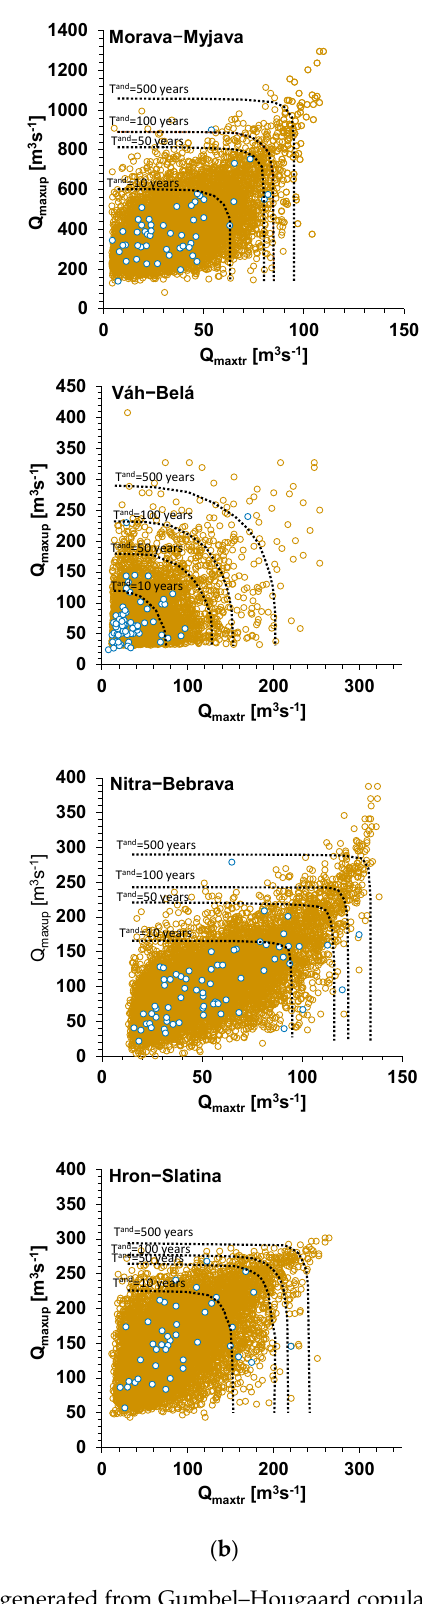
11 of 17 Figure 6. The joint empirical probability (points) and Gumbel–Hougaard copula at selected rivers and their tributaries (Q maxup − Q maxtr ). Subsequently, the selected copula function was used to generate 9000 pairs of selected combinations of hydrological variables on the monitored river confluences. The generated pairs were used to determine the joint probability distribution using copulas. Subsequently, the joint return periods of the analyzed pairs of the annual maximum discharges Q maxup − Q maxtr were estimated. Figure 7 illustrates the scatter plot of the monitored annual maximum discharges and values generated by using the Gumbel– Hougard copula. Figure 7 also illustrates the isolines of the joint return periods “or” and “and”, which are the level curves of the Gumbel–Hougaard copula of interest if the variables exceeded the outward bounds and inward bounds, respectively. The extreme values of the combined discharges’ joint return periods were calculated, (i.e., the maximum discharge resulting from combinations of discharges of the